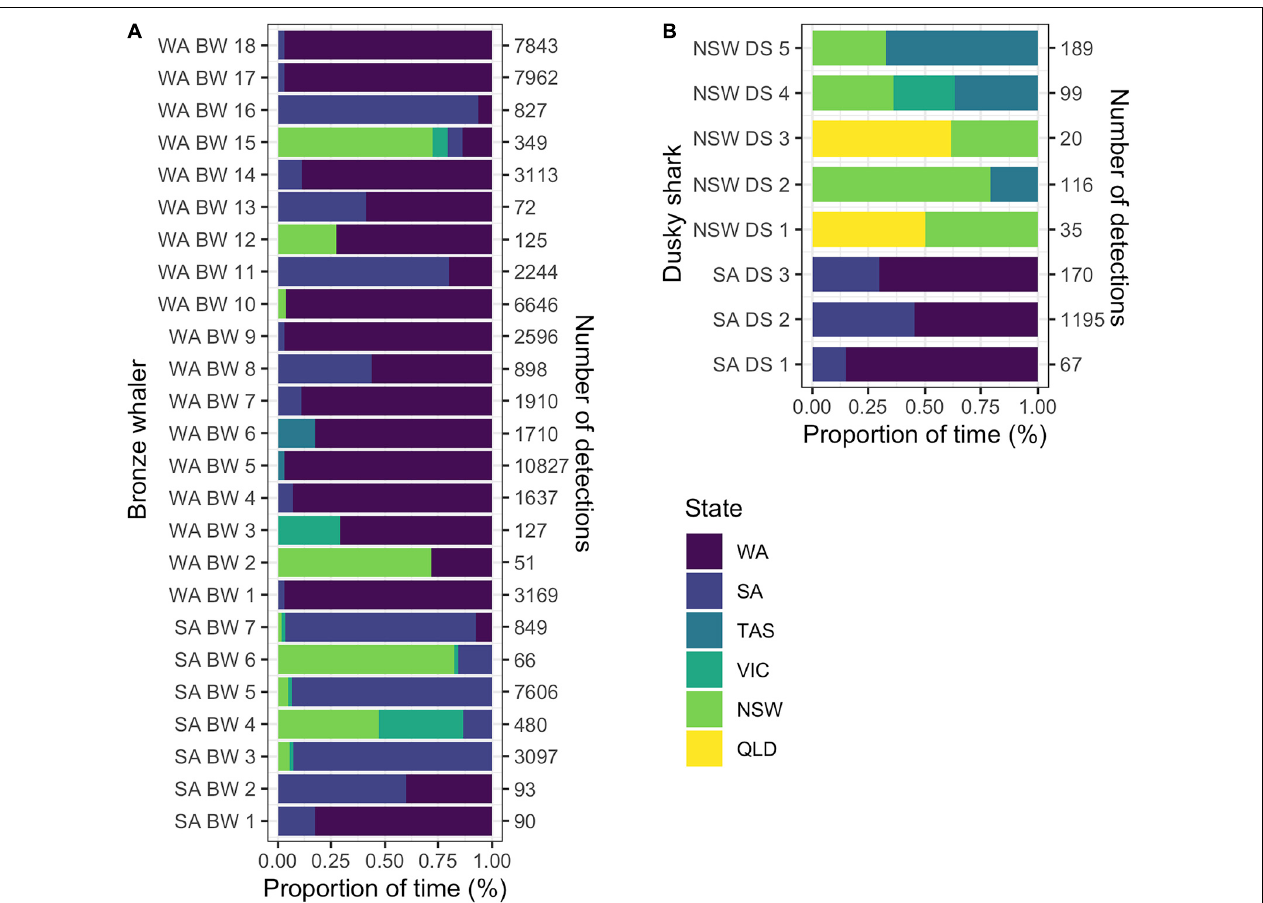
FIGURE 3 | Proportions of time spent by (A) bronze whalers and (B) dusky sharks in each state (color scale: WA, Western Australia; SA, South Australia; VIC, Victoria; and NSW, New South Wales) for the individuals detected at multiple states. Naming legend is composed by the state where the individual was tagged (SA, South Australia; WA, Western Australia), species (BW, bronze whaler; DS, dusky shark) and shark